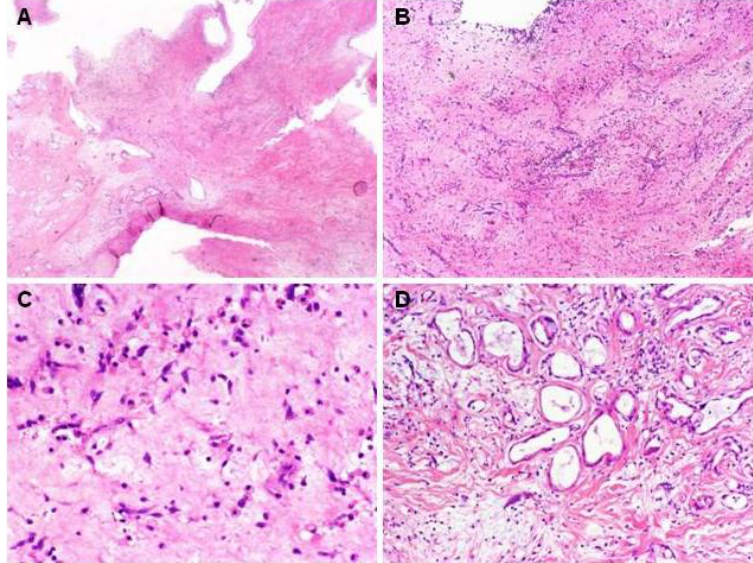
FIGURE 2. (A–D) Histology of the atrial myxoma. The tumor shows a lobulated and frond-like surface, and an abundant myxoid stroma with single spindle and stellate cells. Also present are some inflammatory cells (A, HE 20  ; B, HE 40  ). The spindle and stellate myxoma cells contain eosinophilic cytoplasm and uniform round or oval nuclei (C, HE 200  ). In some areas, the myxoma shows foci of glandular differentiation (D, HE 100 